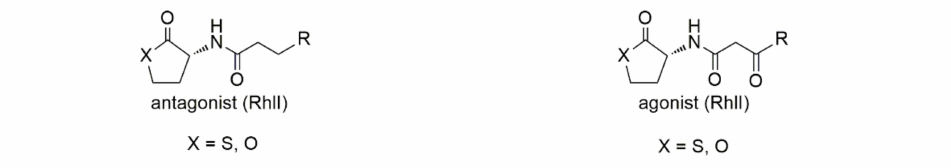
Figure 5. QS modulators for synthase RhlI protein in P. aeruginosa